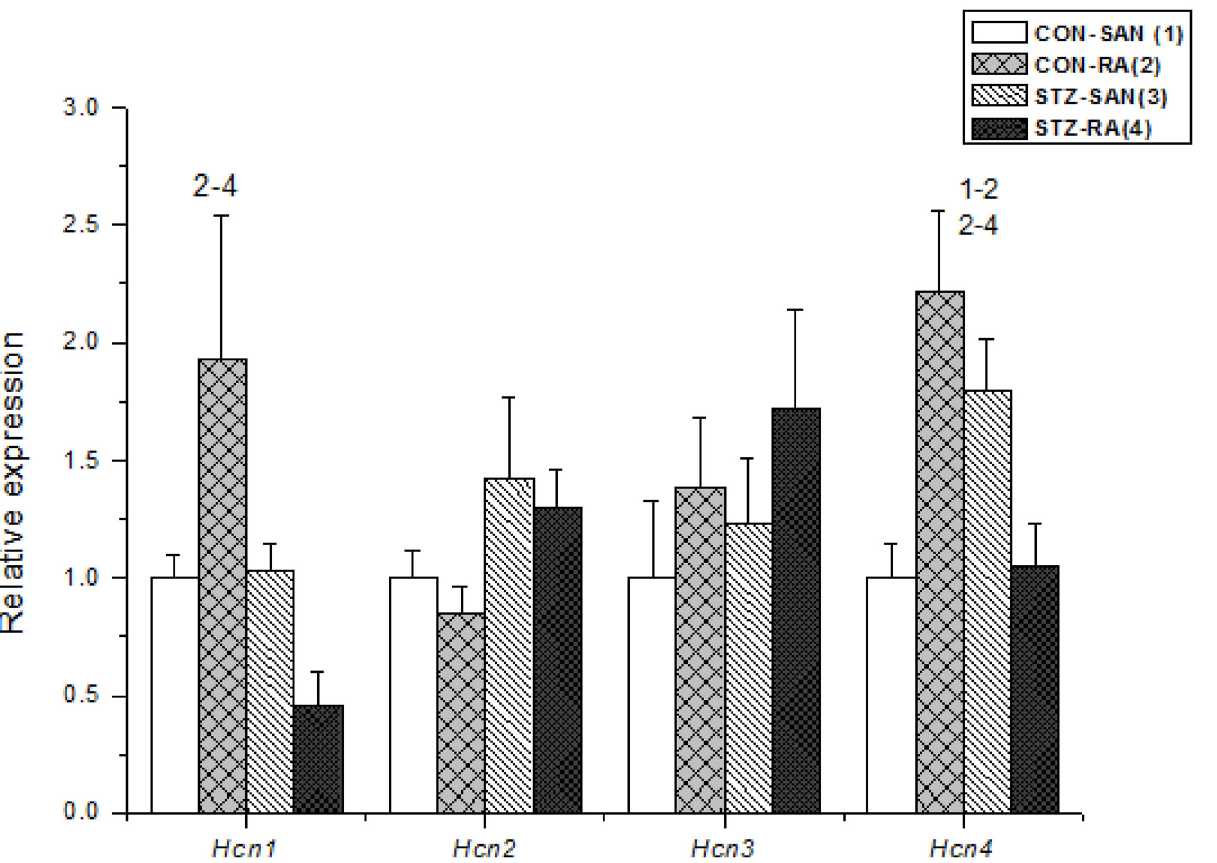
Fig 6. Expression of genes encoding various hyperpolarization-activated cyclic-nucleotide-gated channels. Data are mean ± SEM, n = 5 – 10 samples from STZ and control rat each containing SANs from 2 hearts.